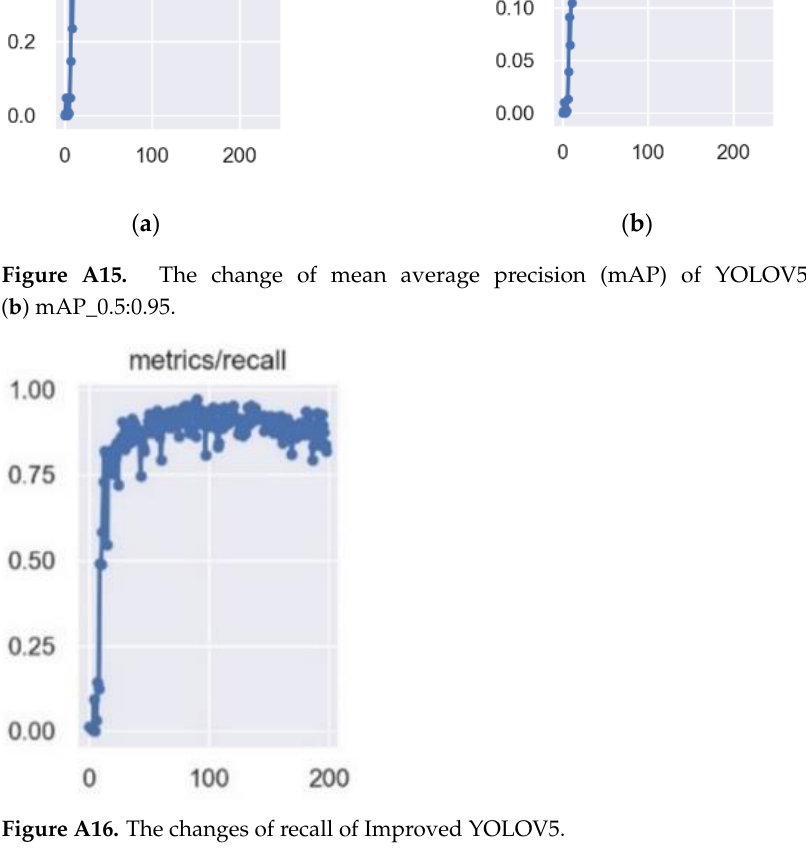
Figure A16. The changes of recall of Improved YOLOV5.